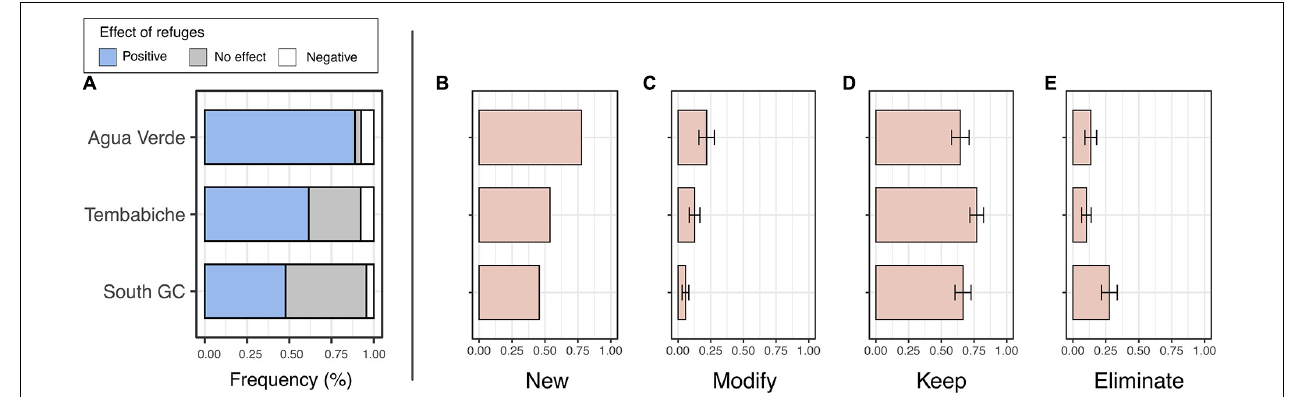
FIGURE 6 | Effect of perception of positive ecological changes on likelihood of proposing new refugia and expanding existing ones, based on 2016 social science survey. Individual survey responses are aggregated by community in the north (Agua Verde, Tembabiche) and together in the south, where fishing zones overlap, and multiple communities had to negotiate each refugia (see Table 2 ). (A) shows proportion of individuals who reported perceiving positive, neutral, and negative ecological effects of the refugia on fisheries. (B–E) show proportion of fishers who: proposed new refugia (B) , proposed to modify (mostly expand, see Supplementary Material 1 ) existing refugia (C) , proposed to keep existing refugia (D) , and proposed to eliminate existing refugia (E)